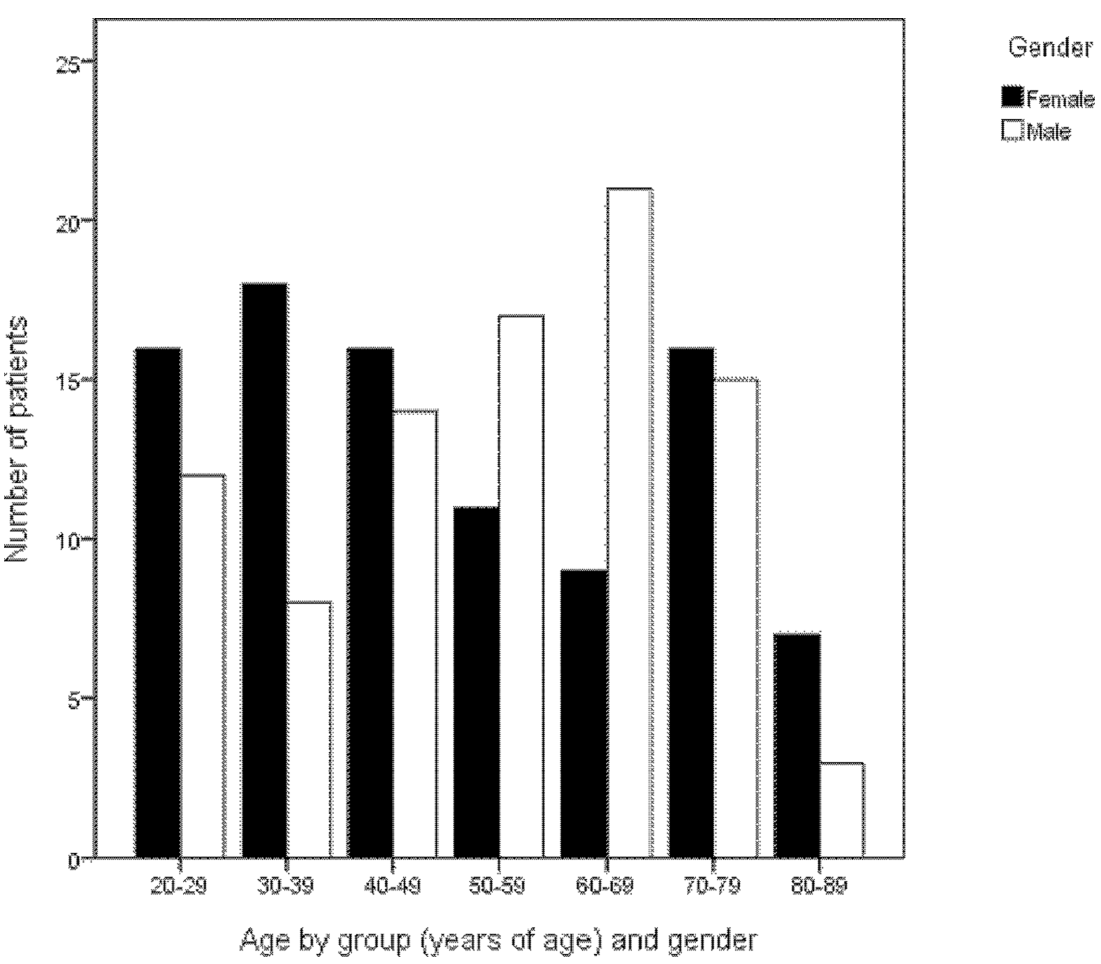
Figure 2. Distribution of age and gender in 183 individuals.